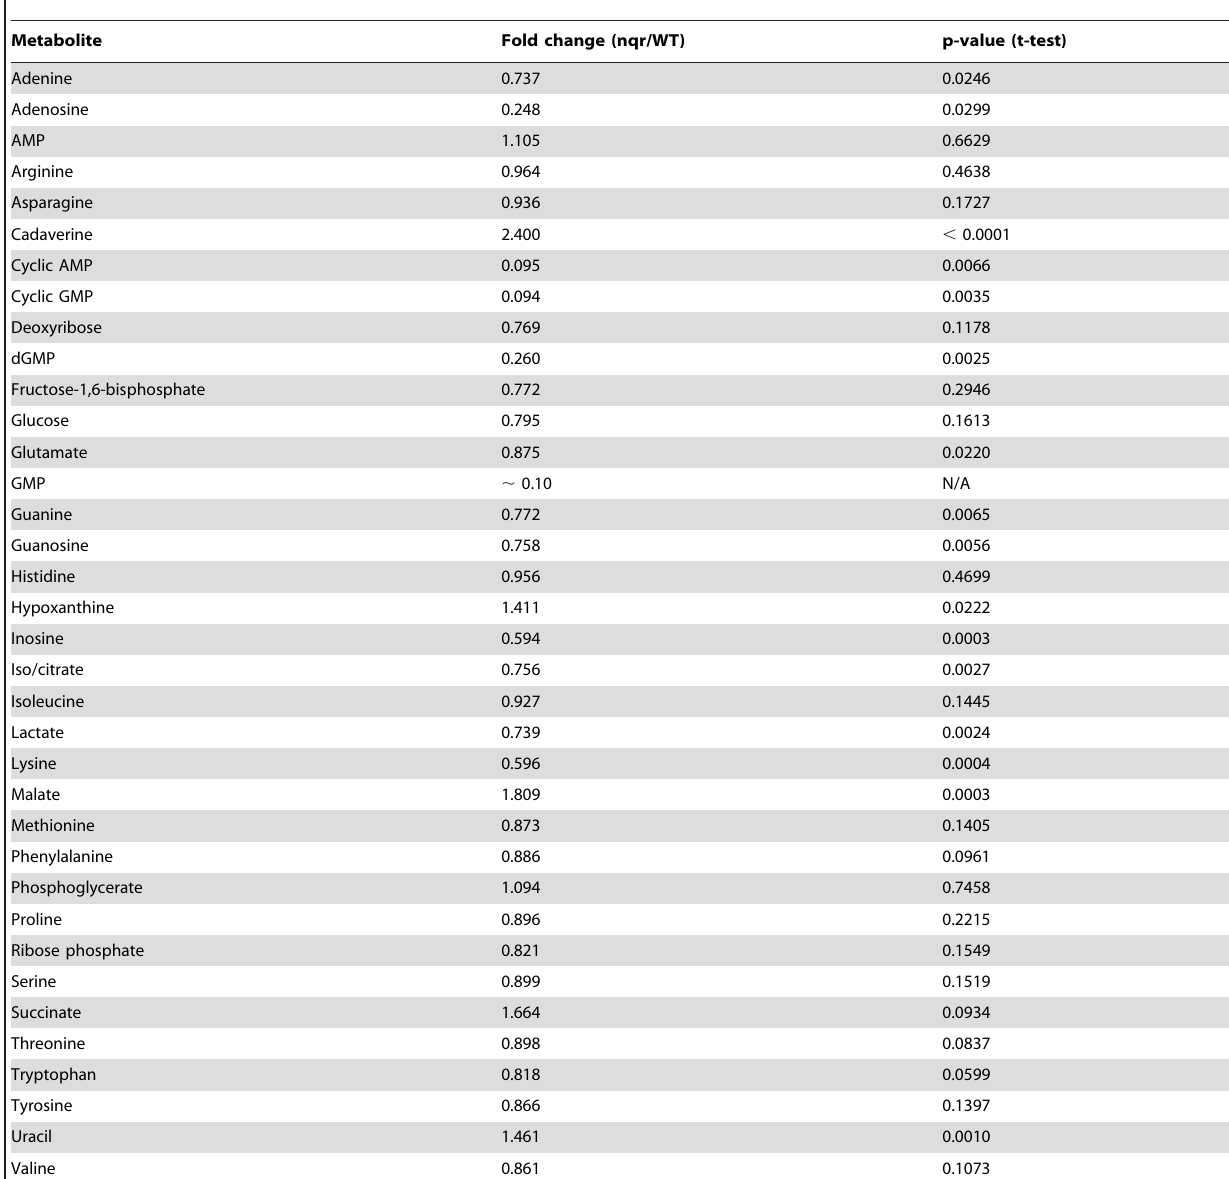
Table 3. Metabolites changed in the D nqrA-F mutant based on metabolomics